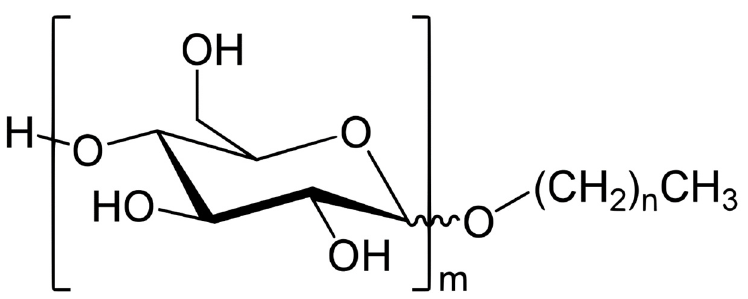
Figure 3. Chemical structure of alkyl polyglucoside [52].